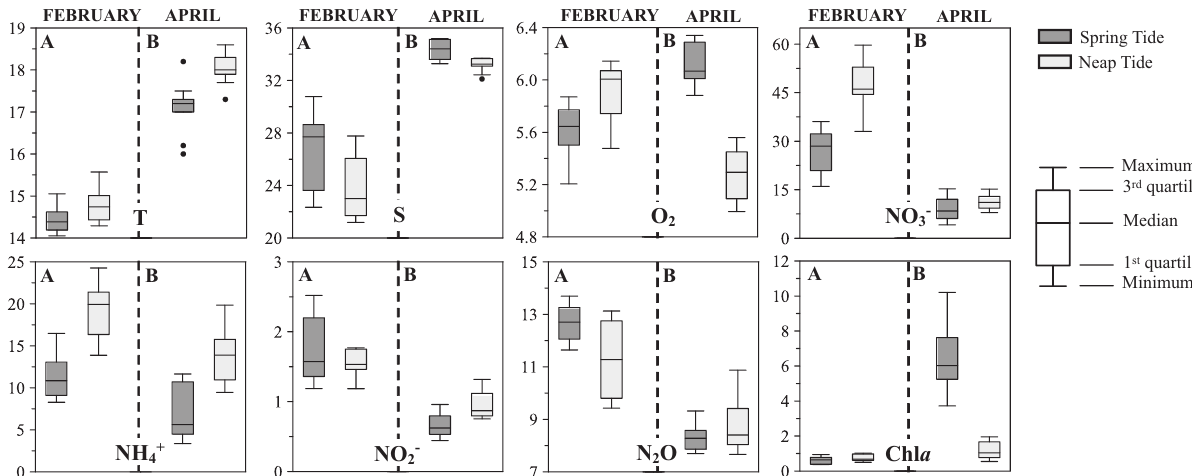
F ig . 4. – Box plots of temperature (T) (ºC), salinity (S), dissolved oxygen (O (N O) (nM) and Chlorophyll a (Chl a ) (mg m -3 ) in (A) February and (B) April 2007, during spring and neap 2